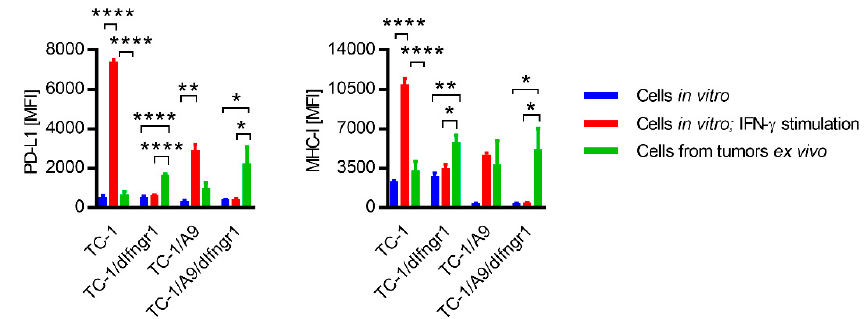
Figure 3. Ex vivo analysis of PD-L1 and MHC-I surface expression by tumor cells. Cells (3 × 10 4 ) were s.c. injected into C57BL / 6 mice ( n = 3) to form tumors. Cells harvested from tumors were stained by specific antibodies and analyzed by flow cytometry. CD45 - tumor cells were compared with cell lines. In vitro cultured cell lines were untreated or stimulated for 1 day with 200 IU / mL IFN- γ . Median fluorescence intensity, MFI; columns, means of three samples; Bars, ± SEM. * p < 0.05, ** p < 0.01, **** p < 0.0001.